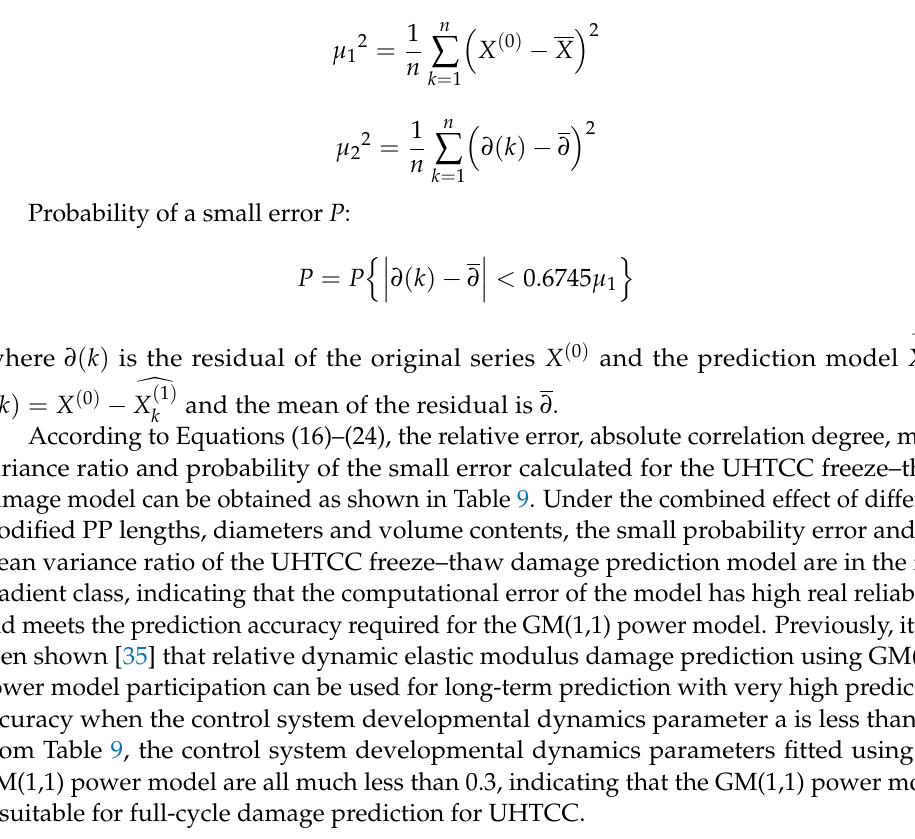
Table 9. GM(1,1) power model error